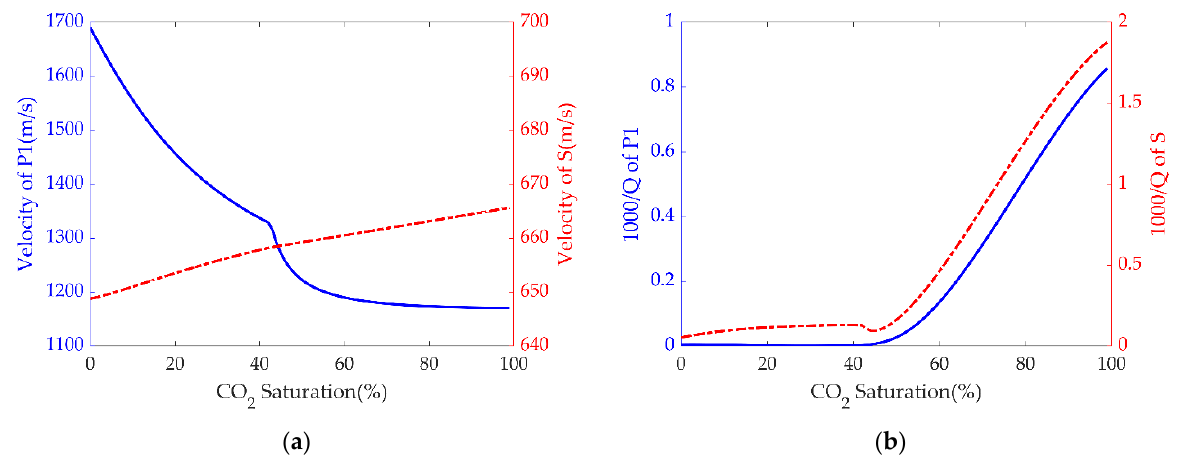
Figure 3. Effect of CO 2 saturation on the velocities and attenuations of P1 and S, f = 100 Hz, P = 10.3 MPa, T = 45 °C: ( a ) phase velocities of P1 and S; ( b ) attenuations of P1 and S.